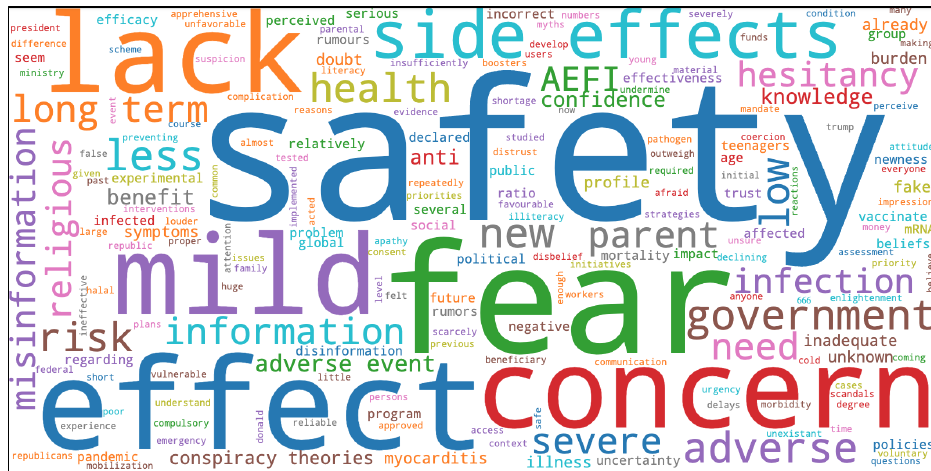
Figure 4. Reasons for COVID-19 hesitancy in children reported by a survey of global vaccination experts are shown in a word cloud where more frequent responses are represented by a larger word size.